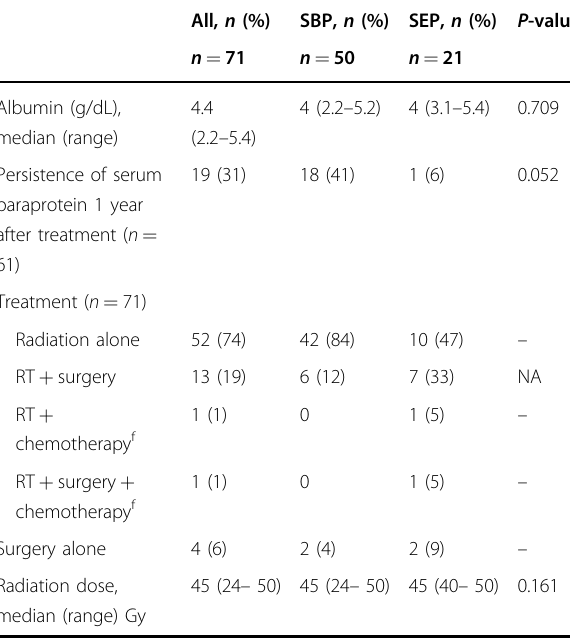
Table 1 Baseline patients ’ characteristics and treatment pro fi